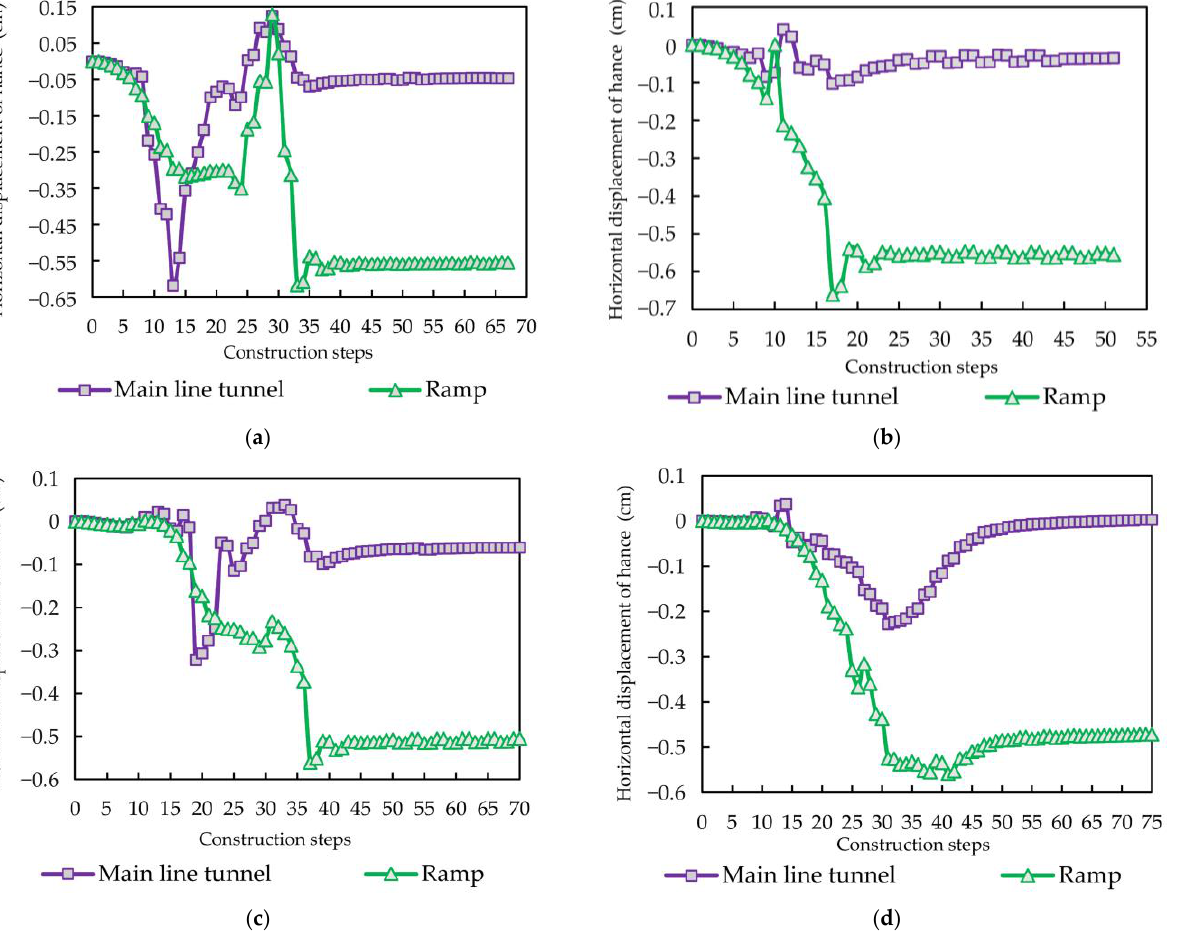
Figure 10. Horizontal displacement of hance in small clear distance section: ( a ) Step method; ( b ) Full section method; ( c ) CD method; ( d ) Double wall heading method.